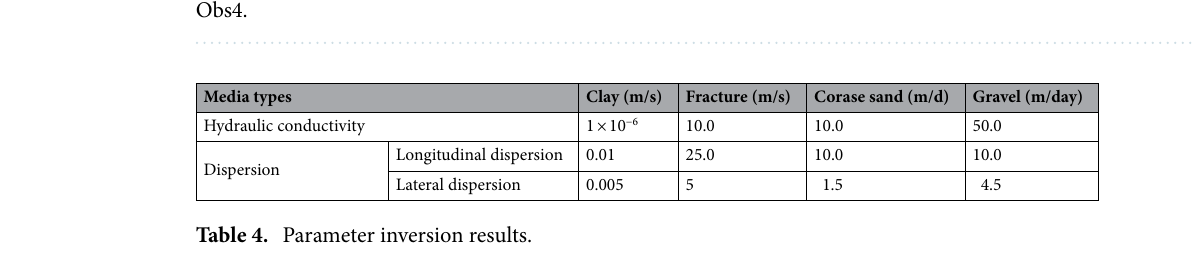
Figure 4. Comparison of experimental and numerical simulation results. ( a ) Obs1, ( b ) Obs2, ( c ) Obs3, ( d ) Obs4.